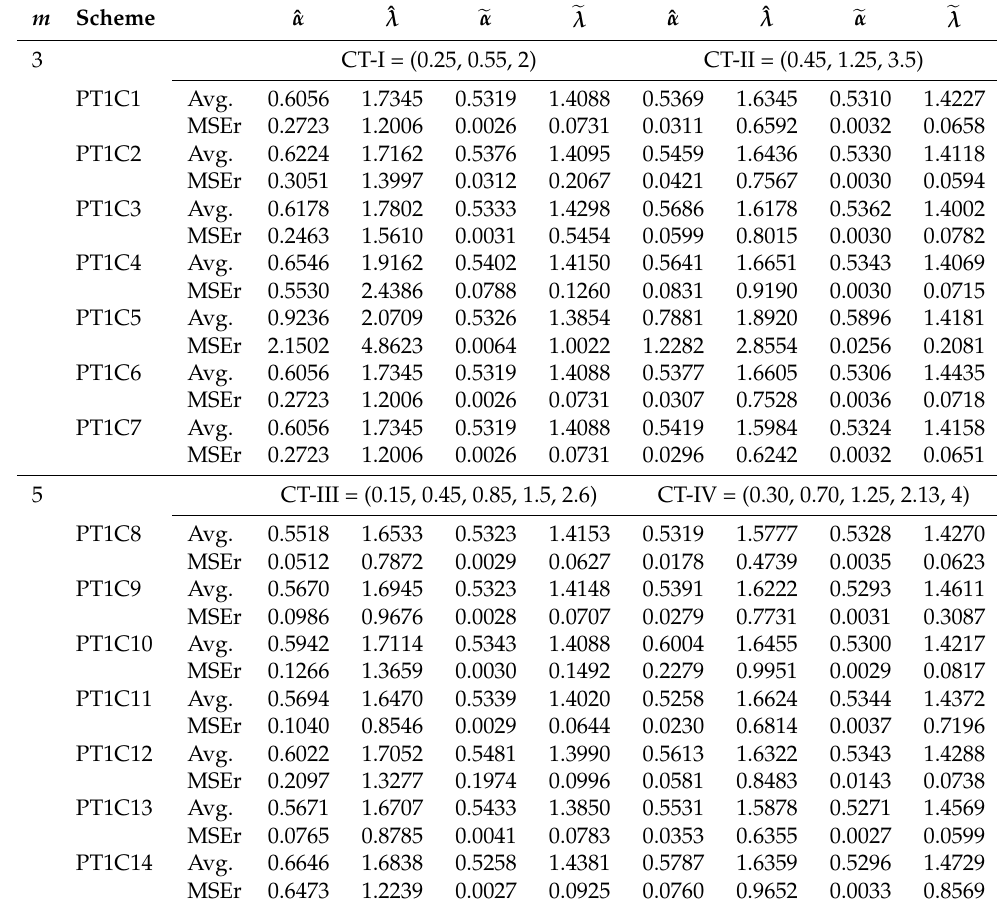
Table 4. Average estimated values and MSErs of the ML and BEs for NH model with α = 0.5 and λ = 1.5 under various censoring schemes at n =